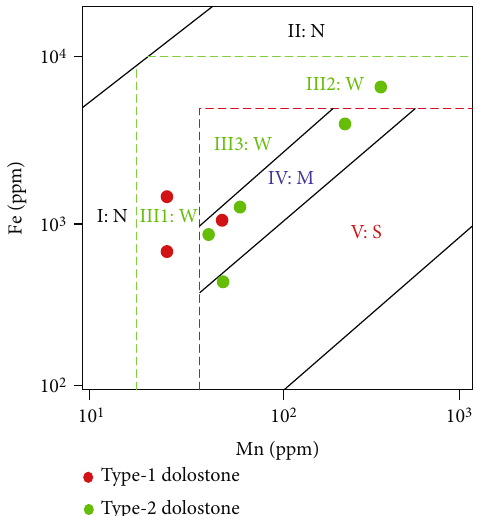
Figure 7: Plot of Mn versus Fe contents for submember Ma5 , III , III , IV, and V represent di ff erent cathodoluminescence intensity regions. S =strong cathodoluminescence, M =medium III 1 2 3 cathodoluminescence, W=weak cathodoluminescence, and N =non cathodoluminescence).